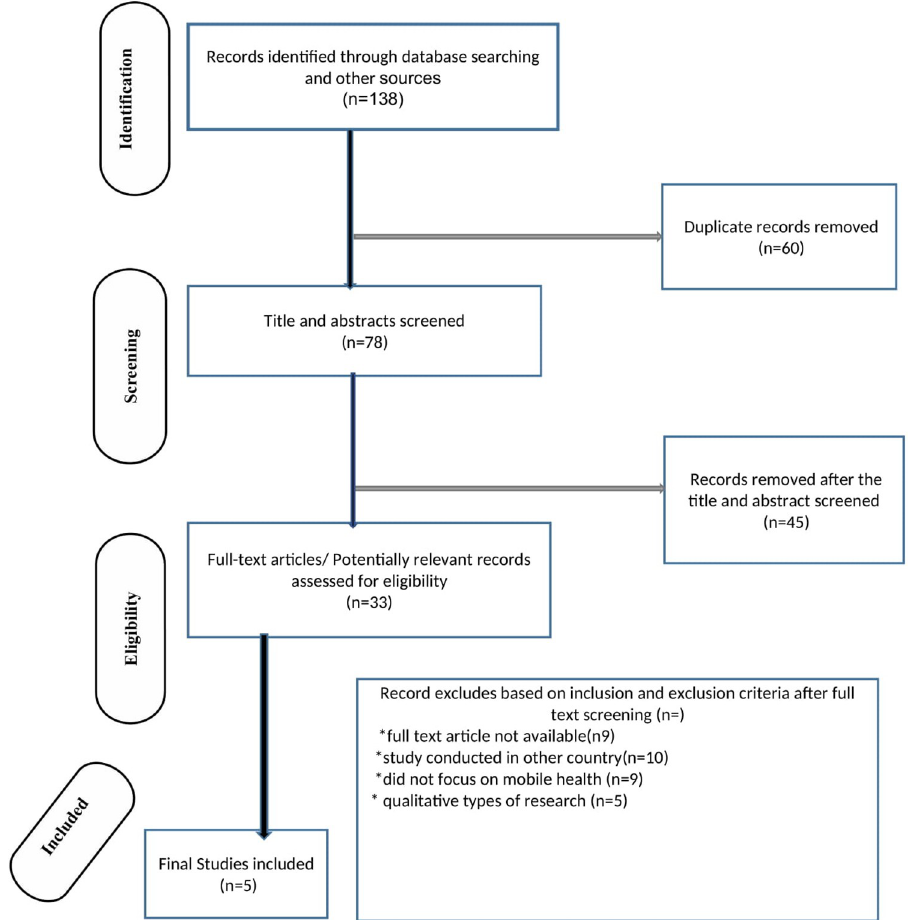
Fig 1. Diagram of study selection for systematic review and meta-analysis of eHealth literacy and associated factors in Ethiopia, 2022.